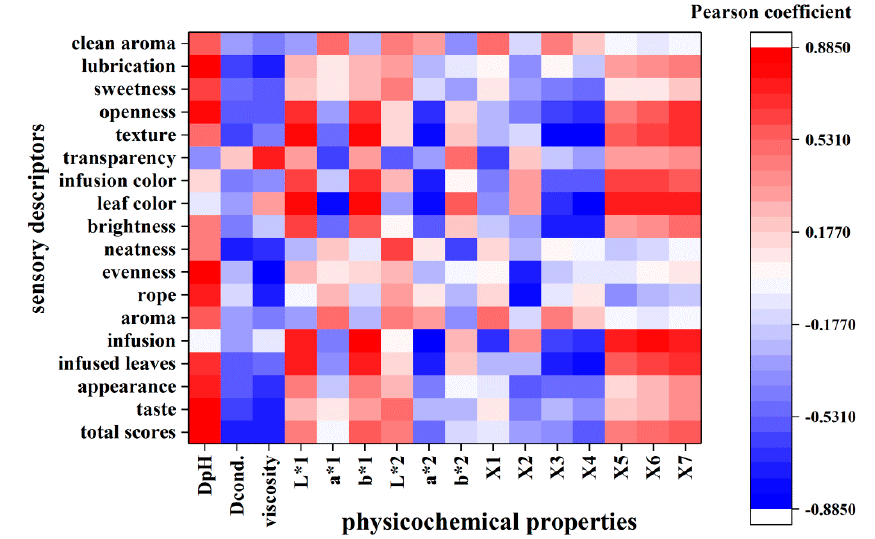
Figure 3. The heat-map based on the Pearson coefficient.